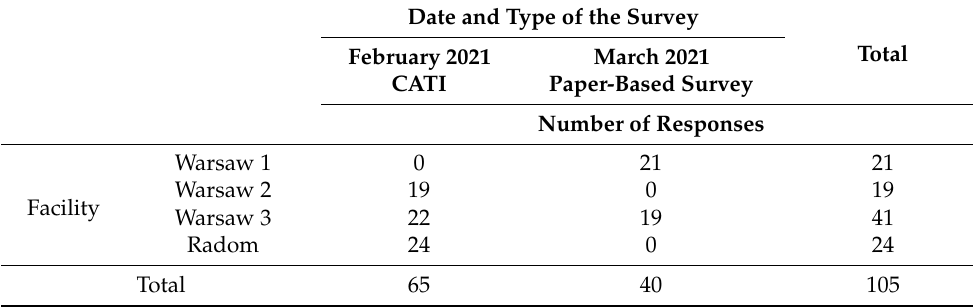
Table 1. Structure of the survey responses.